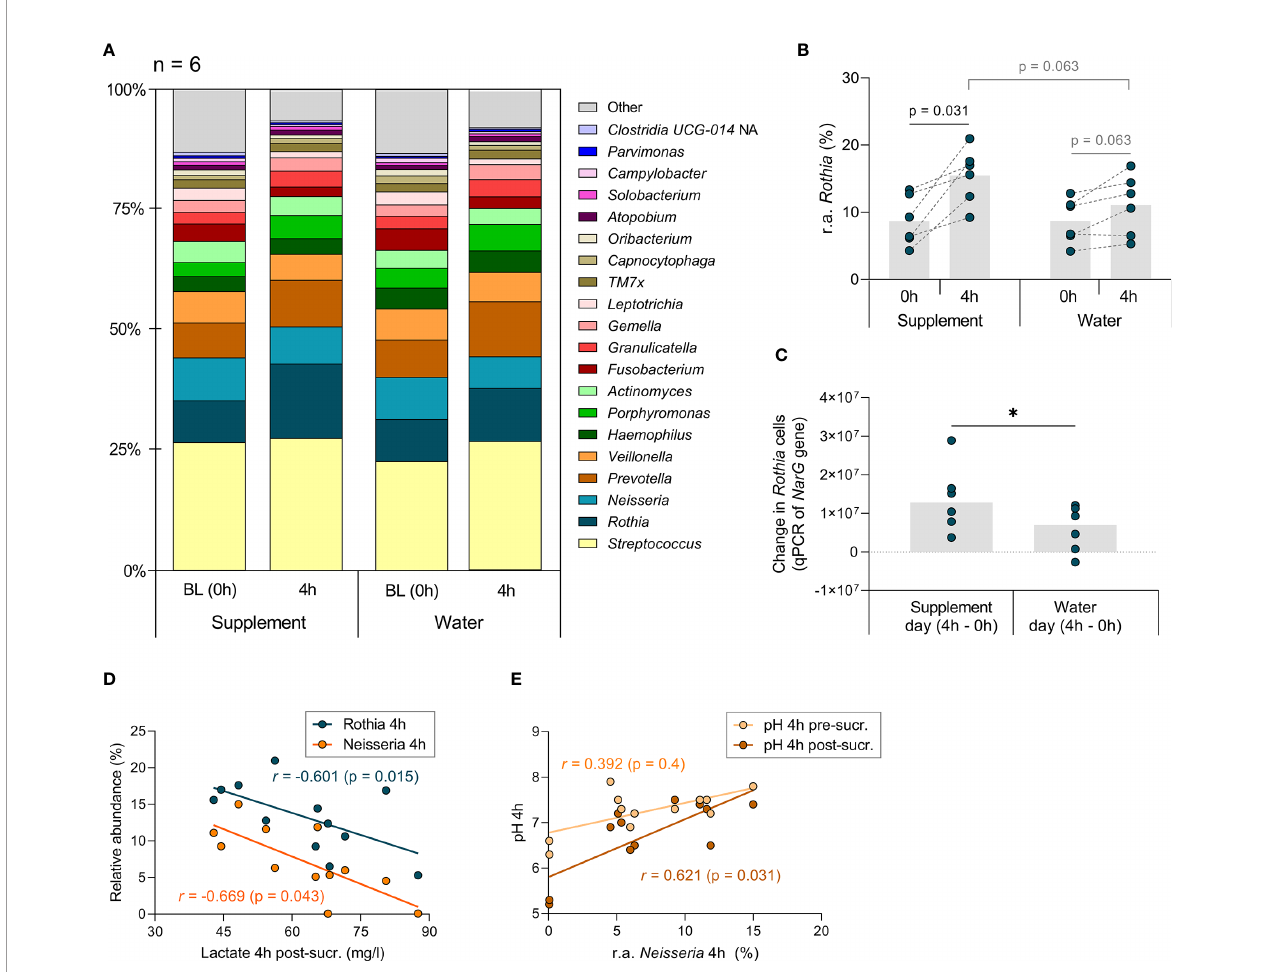
FIGURE 7 | Genus level analysis of study 3 (comparing a nitrate-rich supplement intake with water intake). In (A) , the relative abundance of the genera detected in the 6 individuals of study 3 are represented in bar charts. Based on the median, the 20 most abundant genera are shown. The grey boxes with “ other ” contain genera < 0.34% abundance grouped together. In (B) , the relative abundance (r.a.) of the genus Rothia is shown, which showed the strongest trend towards an increase when comparing BL (0 h) with 4 h after nitrate-rich supplement intake (p value = 0.031, adjusted p-value = n.s.). The grey bars represent the averages and the dark cyan dots the data from individual participants. The higher increase of Rothia after taking the supplement compared with water intake was con fi rmed by qPCR in (C) the increase of Rothia cells from 0 h to 4 h, based on the number of copies of the Rothia nitrate reductase narG gene, was higher after taking the supplement than after taking water (*p < 0.05). (D) the measurements 4 h after water intake and 4 h after supplement intake were combined (n = 12) and a lactate post-sucrose correlated negatively with the abundance of Rothia and Neisseria . In (E) , the correlation with Neisseria between pH pre-sucrose and pH post-sucrose is shown. Because of the small sample size, unadjusted p-values are